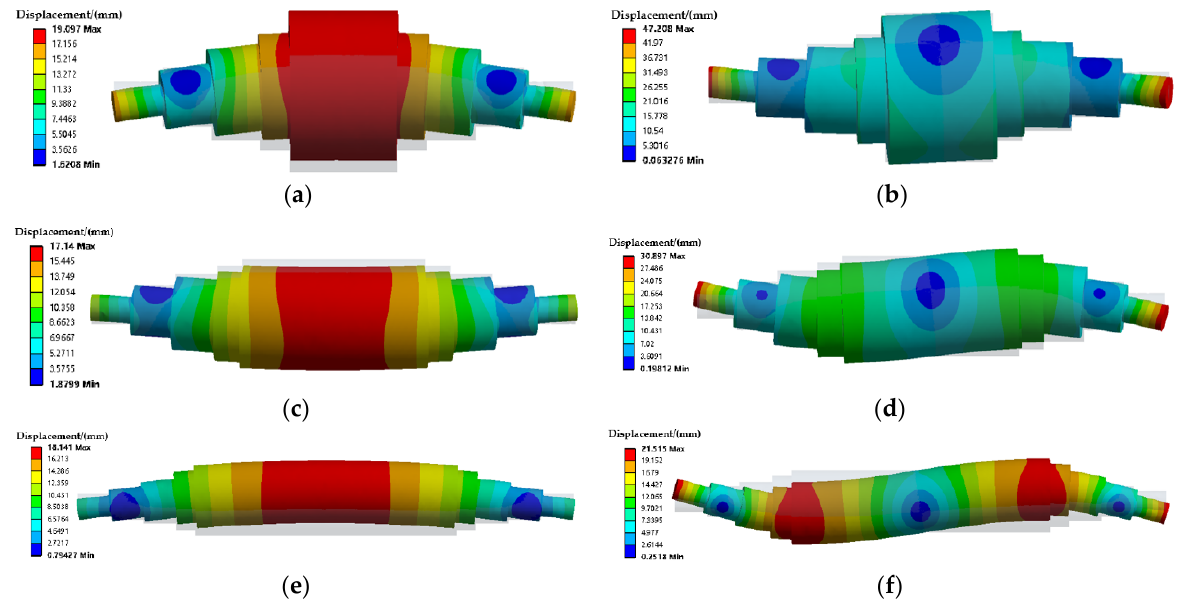
Figure 24. Rotor dynamic characteristics under the three cases: ( a ) first ‐ order mode for Case 1; ( b ) second ‐ order mode for Case 1; ( c ) first ‐ order mode for Case 2; ( d ) second ‐ order mode for Case 2; ( e ) first ‐ order mode for Case 3; ( f ) second ‐ order mode for Case 3.